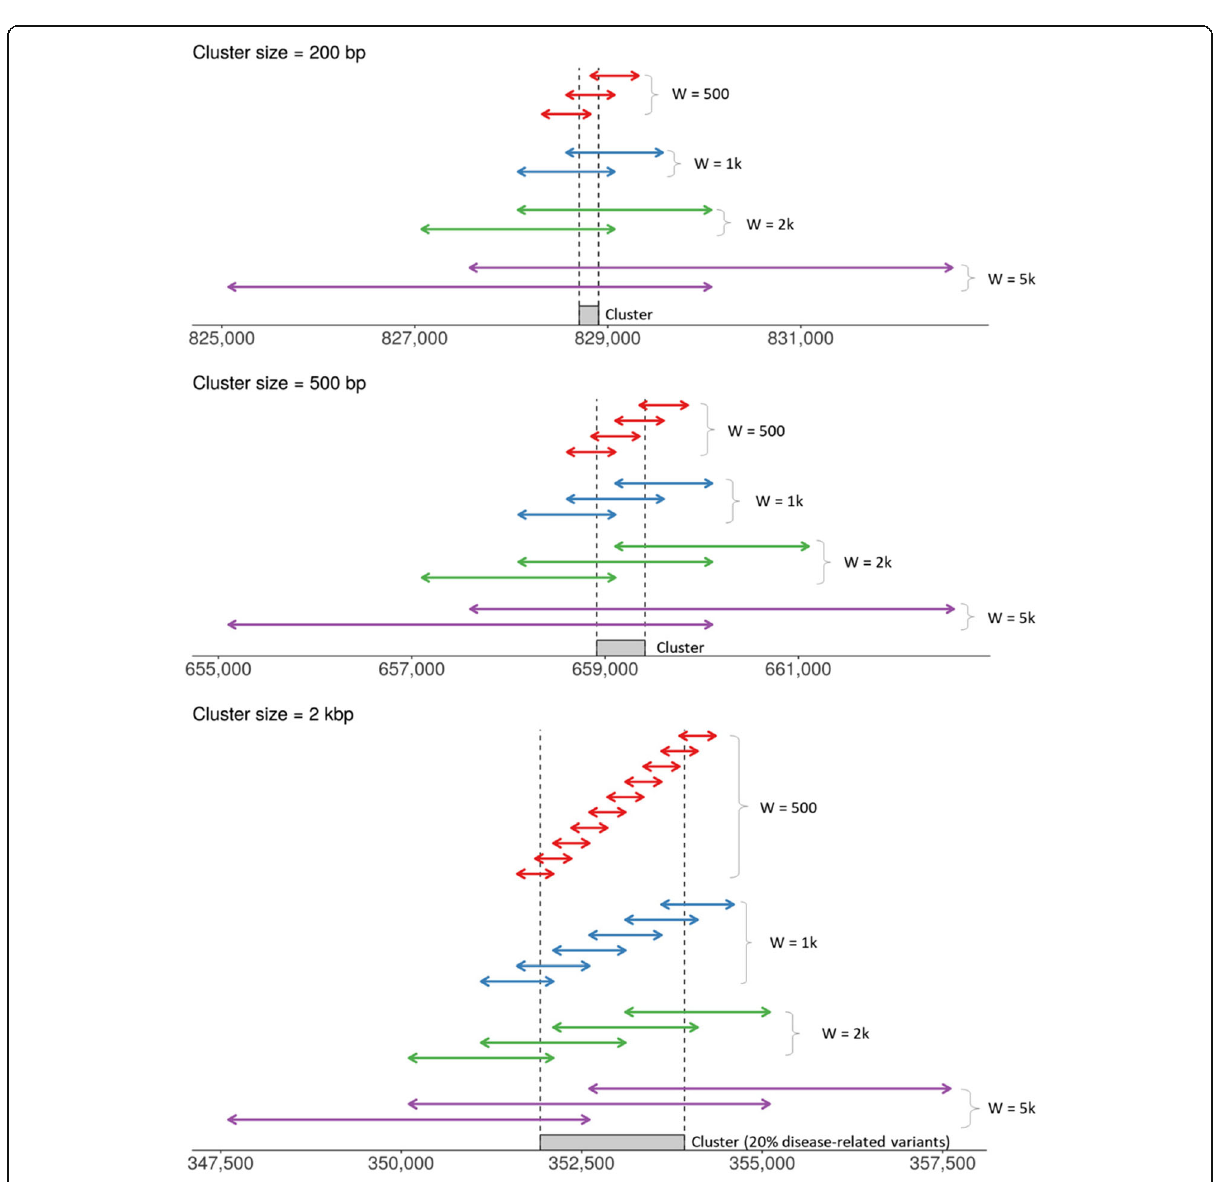
Fig. 1 Cluster and window positions for type I error and power evaluations in each scenario